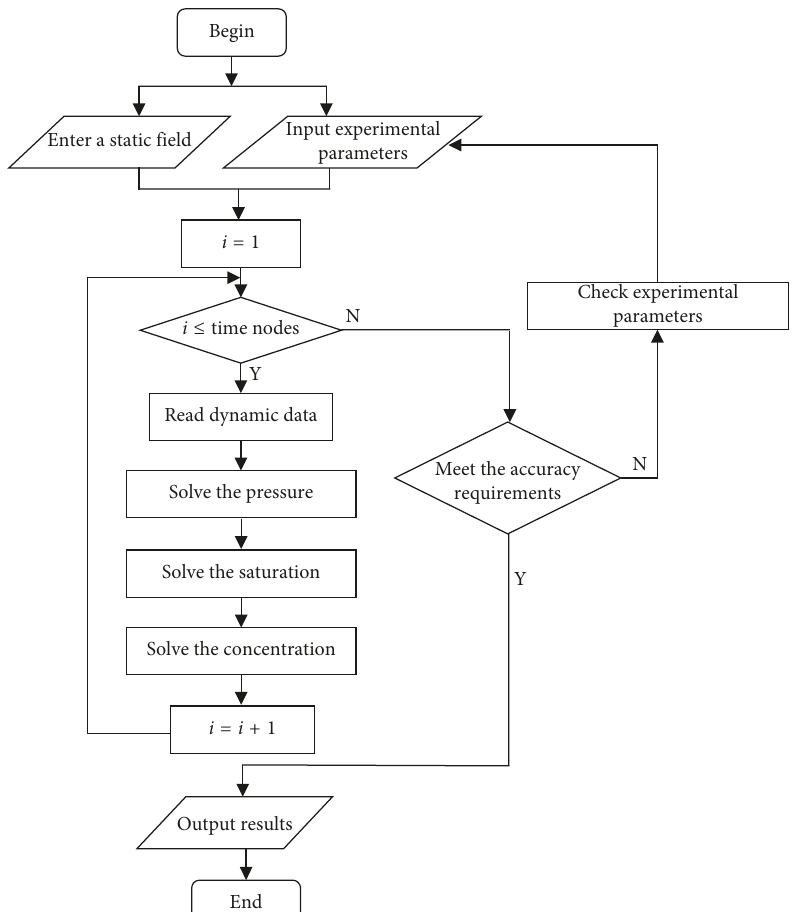
Figure 5: The flow chart of implementation process.